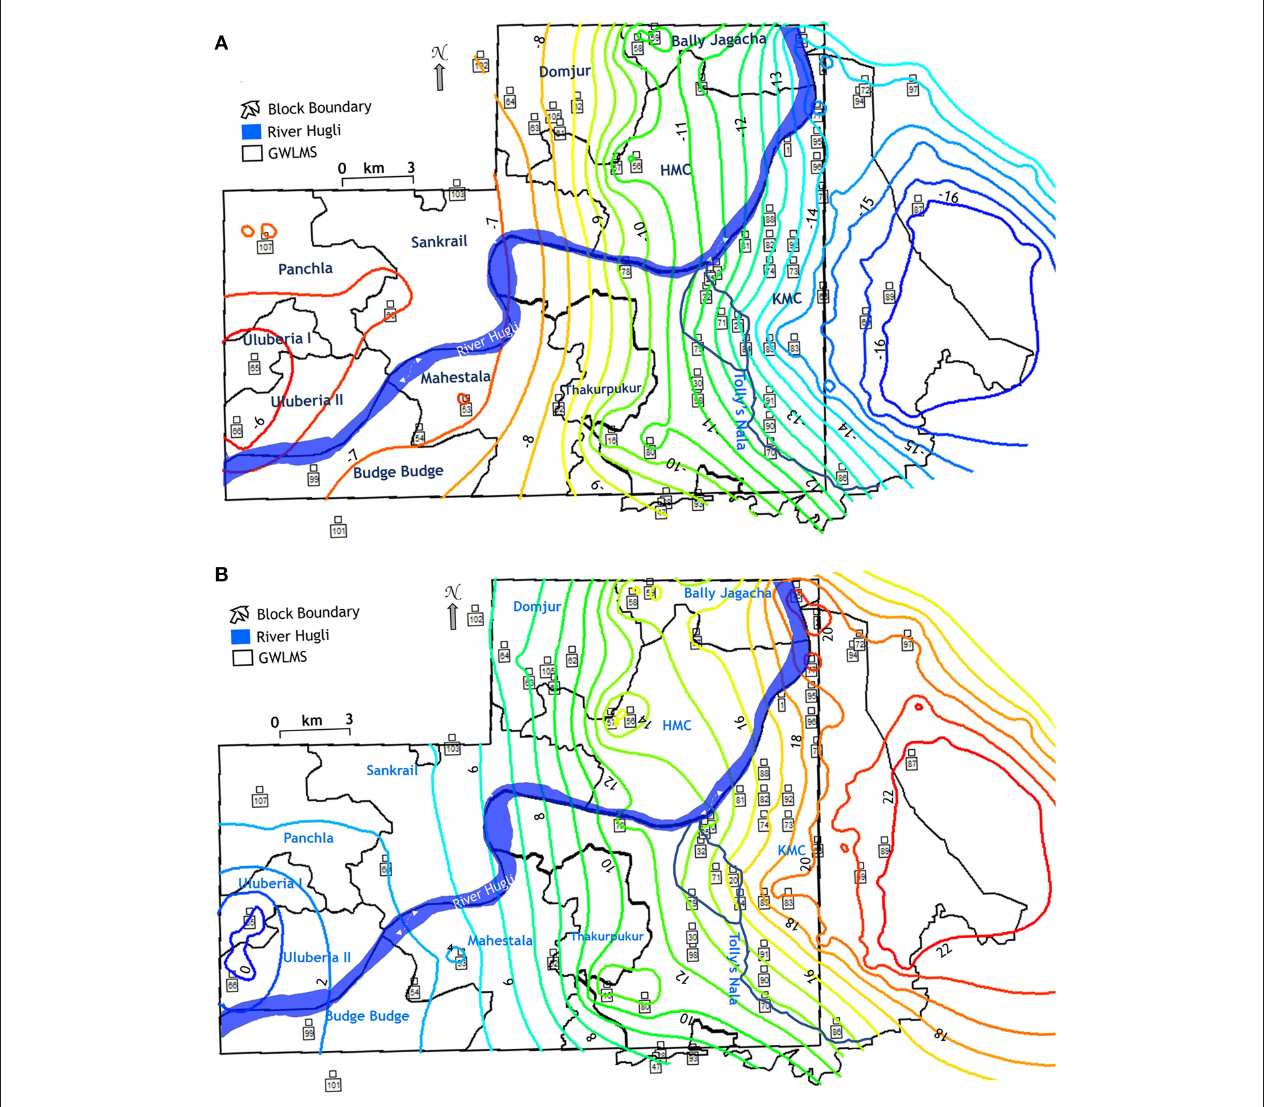
FIGURE 8 | (A) Spatial distribution of heads (depth: 100–120m) of the study area under present development conditions. (B) Spatial distributions of drawdown (depth: 100–120m) with respect to predevelopment of the study area under present development conditions.